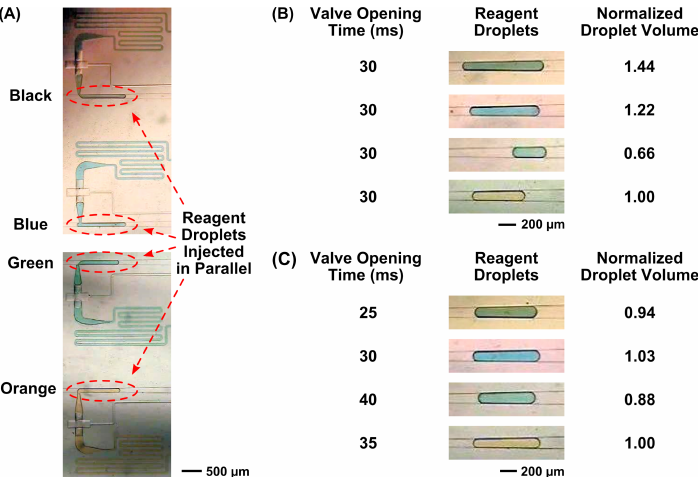
Figure 4. Parallelized Quadplex Injection of Reagent Droplets with Capacity for Individualized Calibration. ( A ) Parallelized injection of multiple reagents can be readily achieved in our device, as a simultaneous actuation of all four reagent microvalves results in four independent reagent droplets in their respective channels. ( B ) Variations in reagent inlet microvalves and differences in the viscosity of food dyes can lead to reagents droplets with different sizes. For example, when we injected four different colors of food dyes with an identical microvalve opening time (e.g., 30 ms), the four resulting reagent droplets can differ by as much as 44% in normalized droplet volume. ( C ) By adjusting the microvalve opening time of each individually-addressable reagent microvalve, reagent droplets with significantly improved size uniformity can be generated.